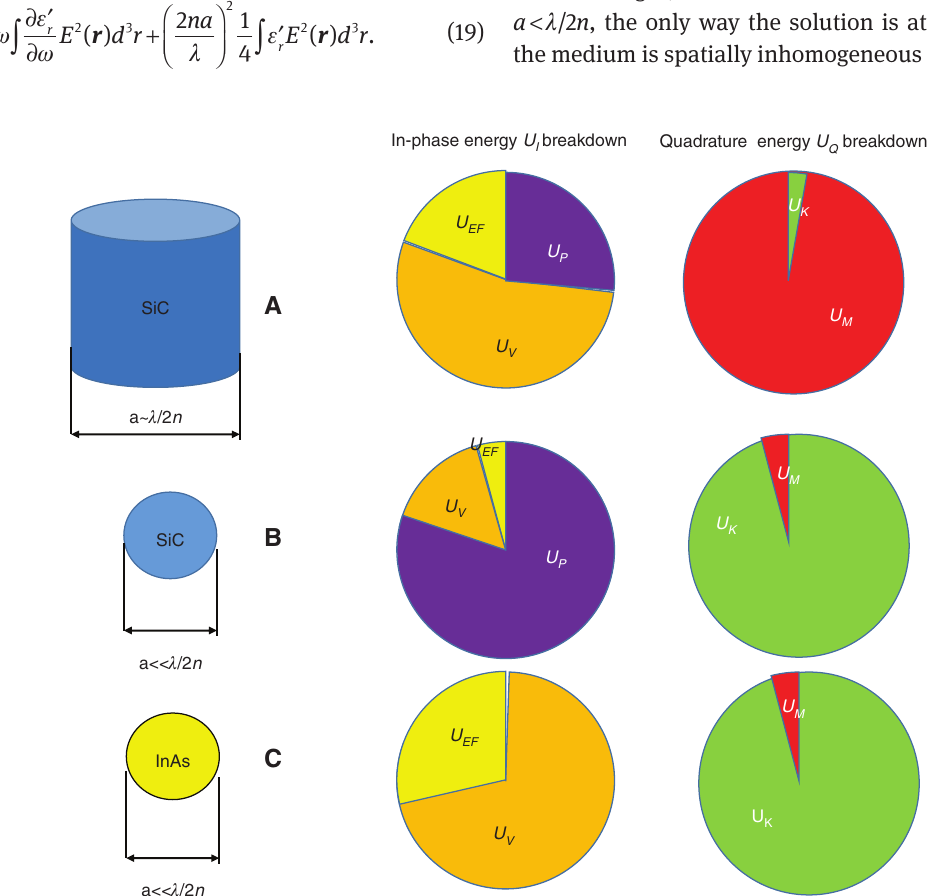
Figure 3: The breakdown of energies in three different resonant structures in the mid-IR region: (A) dielectric resonator, (B) localized surface phonon polariton, and (C) localized surface plasmon